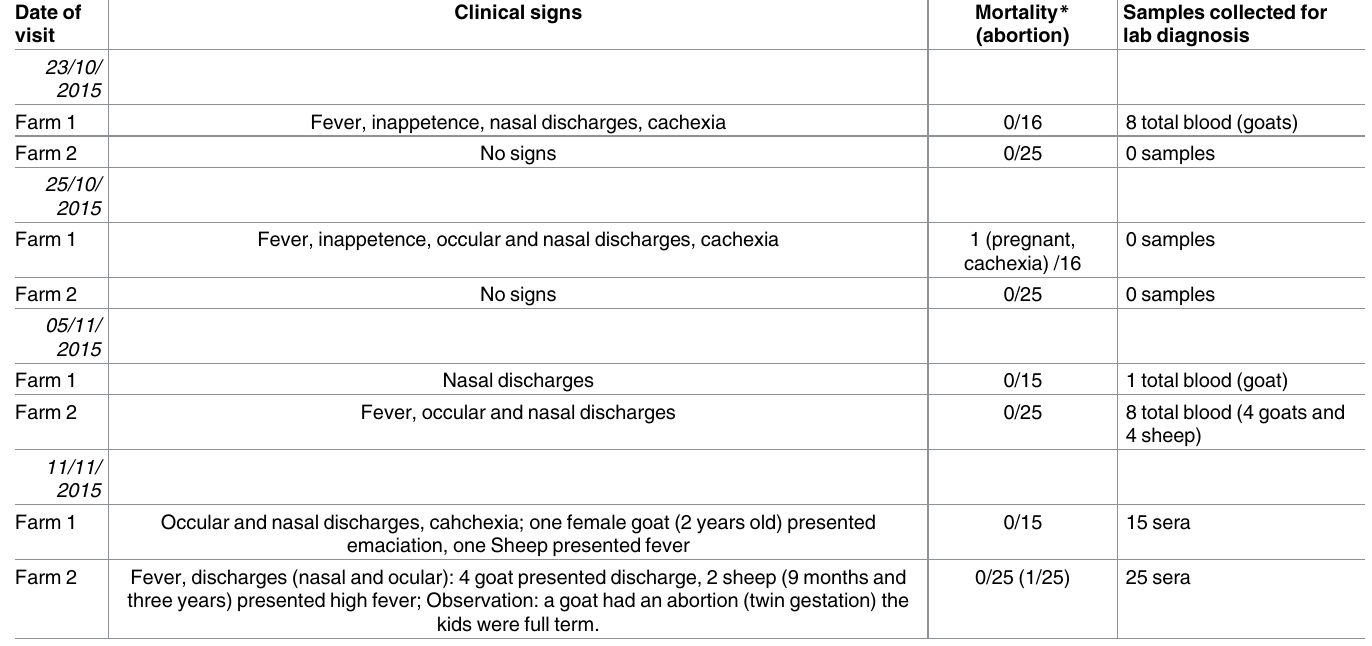
Table 1. DescriptivePPR data and samples used in this